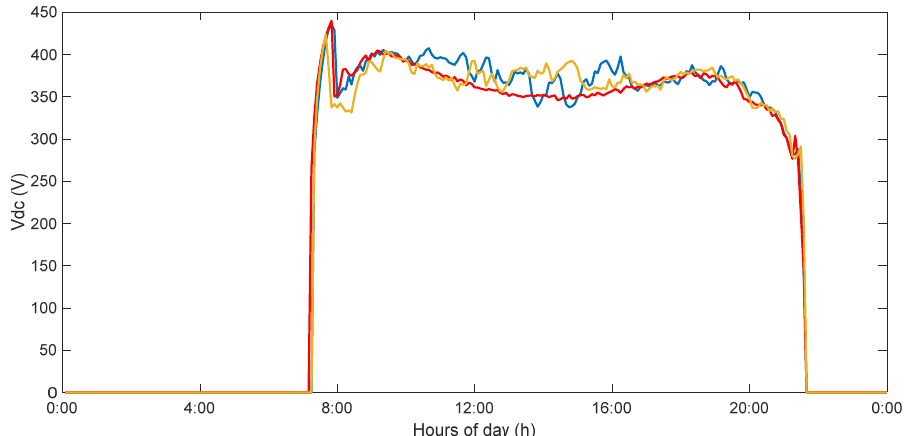
Figure 18. Daily profiles of the working voltage of the PV modules during 12, 14 and 17 May 2011.